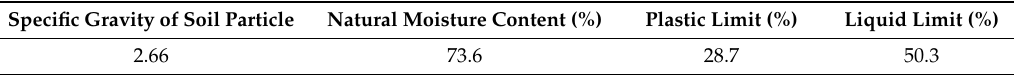
Figure 3. Permeability test mold.